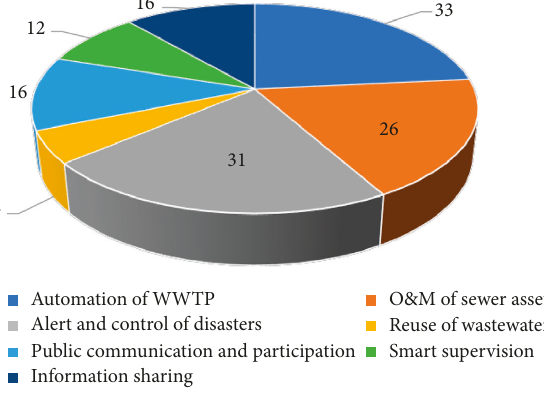
Figure 4: Frequencies of functions in 51 papers. Table 1: Partial results of systematic literature